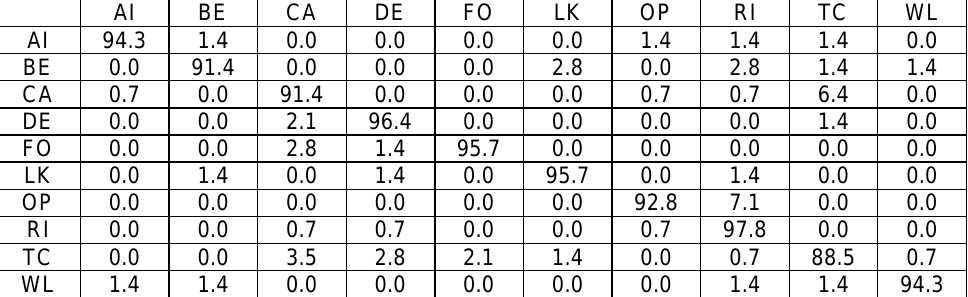
Table 3. Confusion Matrix for VGG-16 Net Model in (%)